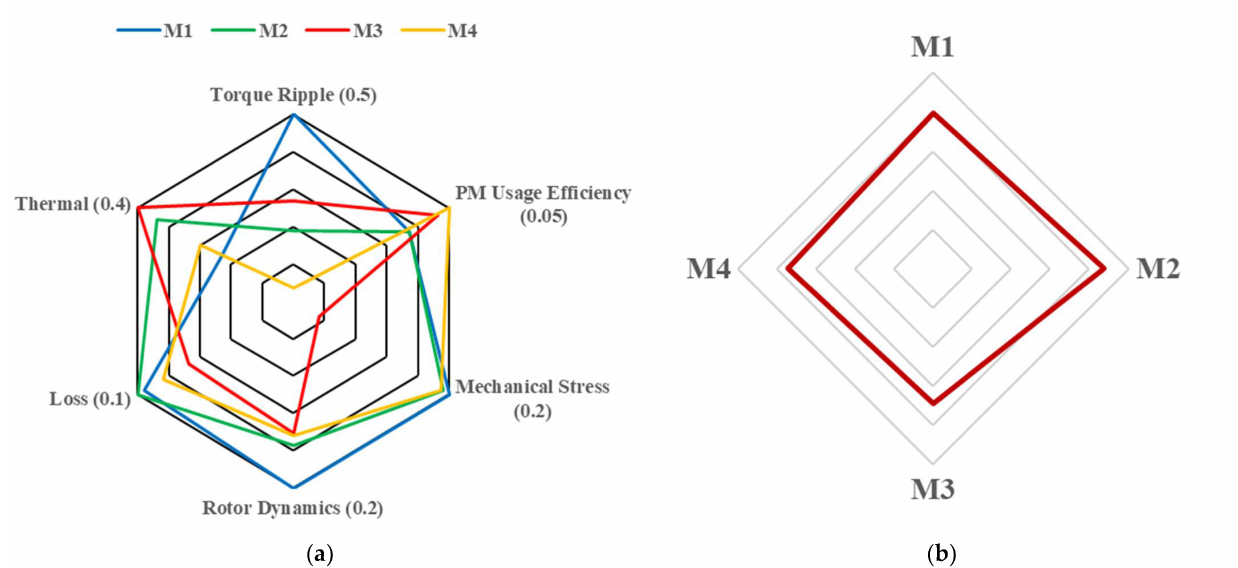
Figure 14. Comparison of different HSPMSMs. ( a ) Quantitative comparison considering single target; ( b ) overall